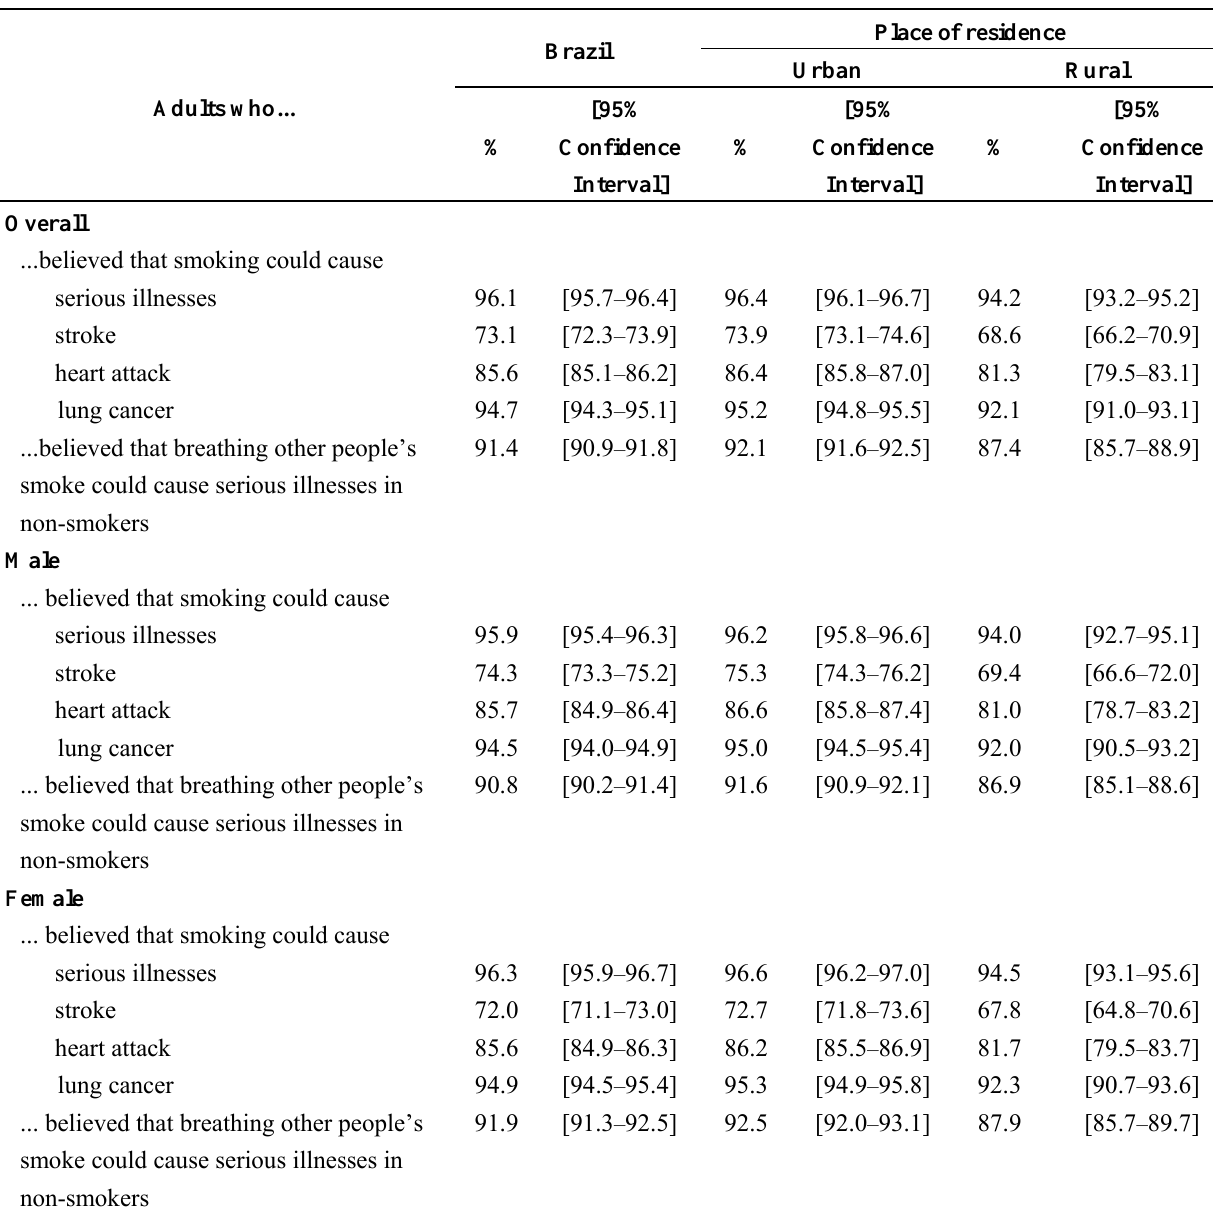
Table 7. Percentage of adults ≥ 15 years old who believed that smoking/breathing other people’s smoke causes serious illness, by place of residence and gender, GATS Brazil, 2008. Place of residence Brazil Urban Rural Adults who...